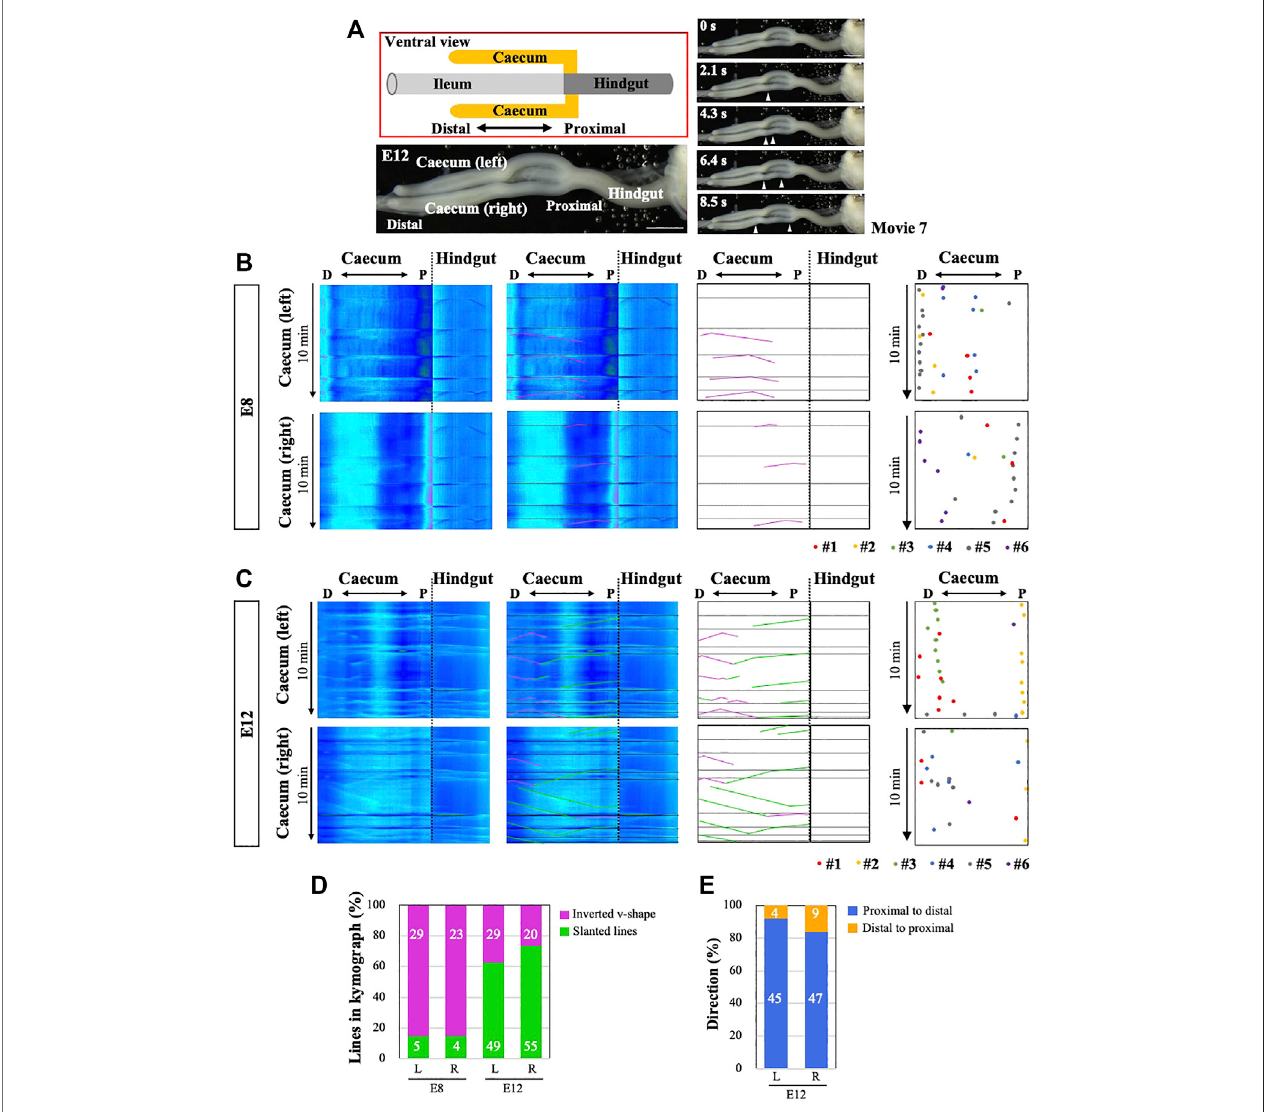
FIGURE 8 | Peristaltic movements and OPW distribution maps in the embryonic caeca. (A) Characteristic caecal structures in chicken embryos. Five frames are selected from Supplementary VideoS7 . (B) Peristaltic movements(v-shaped lines) are detected by E8 in both right and left arms. Horizontal lines are the continuation ofthoseinthehindgutasexplainedin Panel7 .Noleft-right(LR)symmetricpatternsarefound. (C) ByE12,v-shaped(purple)and simplyslantedlines (green)areseenin kymographs.Horizontallinesareasexplainedin (B) .Contrastingwiththejejunum( Panel3 ),nozonesofOPWcon fi nementaredetectedinthecaecaatE8andE12 as shown in the distribution maps for six different embryos for each stage (B, C) . (D) At E8, the majority of peristaltic movements are bi-directional (v-shaped lines with apex), whereas uni-directional movements (slanted lines) dominate later at E12. The number of lines found in the kymograph is shown in bars. (E) The majority of uni- directional movements at E12 are in a proximal-to-distal direction in both right and left arms. The number of lines found in the kymograph is shown in bars. Scale bars: 2 mm.